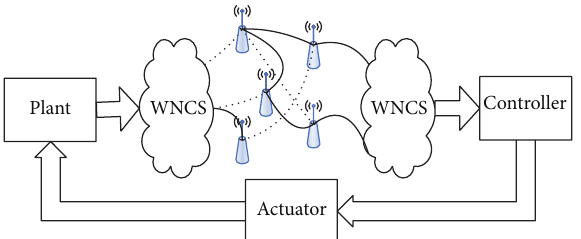
Figure 1: WNCS with stochastic uncertainties and time delays. from plants and then transfer data to other nodes